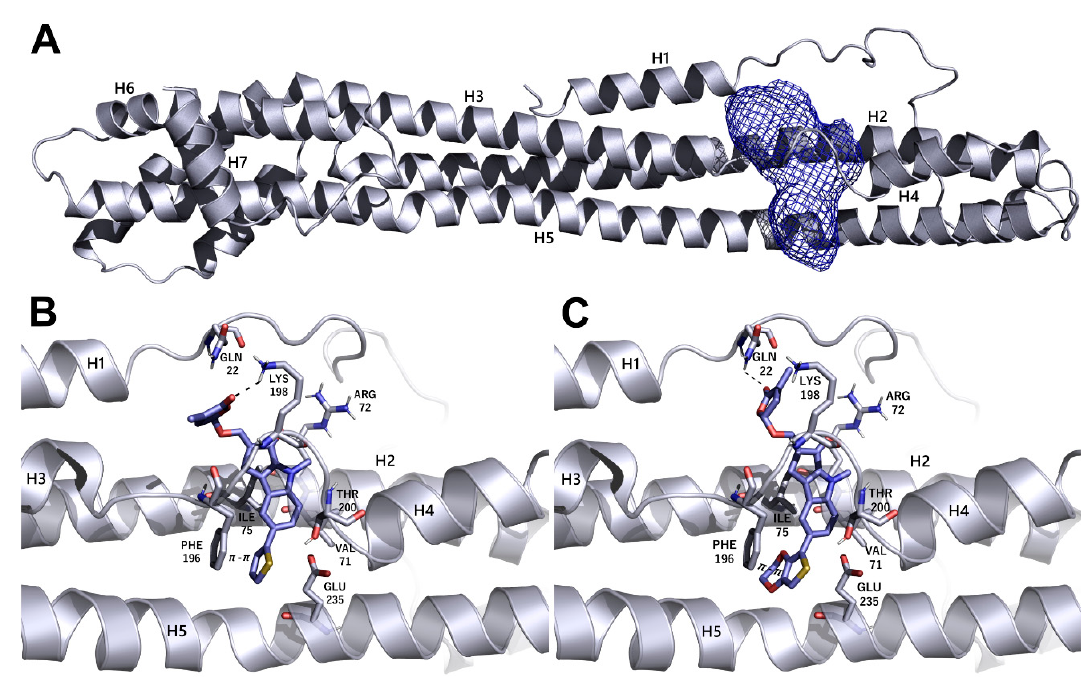
Figure 5. Modeling of the possible complexes formed by IE1 and the most active SL analogs TH-EGO and EDOT-EGO. ( A ) Homology model of IE1. The protein is represented as a cartoon and the selected binding site as a mesh contour. ( B ) and ( C ) Predicted binding pose of TH-EGO and EDOT-EGO in the protein pocket. Hydrogen bonds are shown as black dashed lines. The SLs and the residues lining the pocket are displayed as lilac and grey capped sticks, respectively.